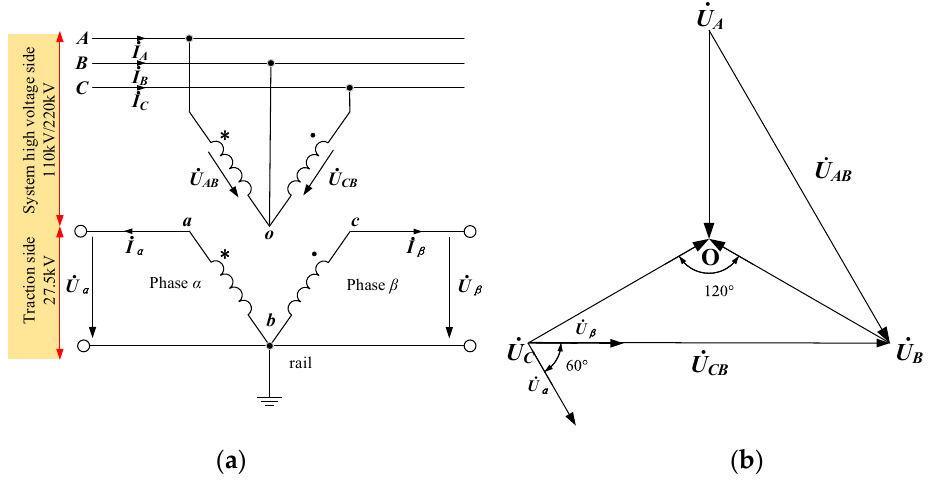
Figure 1. ( a ) Wiring diagram of a V/v wiring traction transformer; ( b ) phasor diagram. A V/v wiring traction transformer can be regarded as the series connection of the high-voltage side windings of two single-phase dual-winding transformers with an equal or unequal capacity. The high-voltage side winding ratios, denoted as w AB and w CB , are set to be the same, i.e., w AB = w CB = w 1 . The common connection point o accesses phase B in the three-phase power system, and the other two terminals are connected to phase A and phase C , respectively. Traction side windings are connected in series, and the traction side winding ratios satisfy the relationship w α = w β = w 2 . The common connection point b is connected to the rail. Terminal a , terminal c , and common connection point b constitute the α port and the β port. The traction side bus voltages are